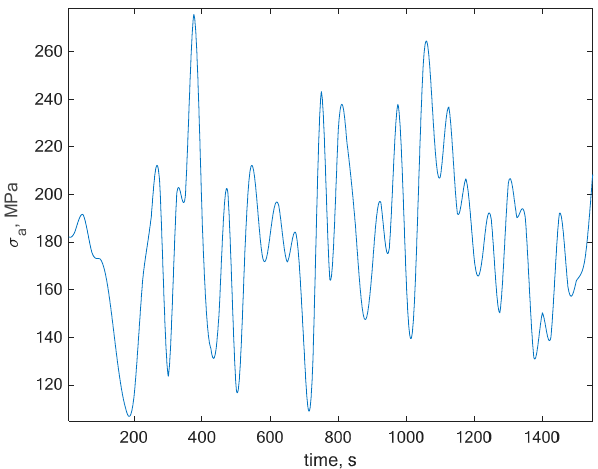
Figure 6. A section of the generated random nonzero mean stress characteristic with the global R = 0.1.